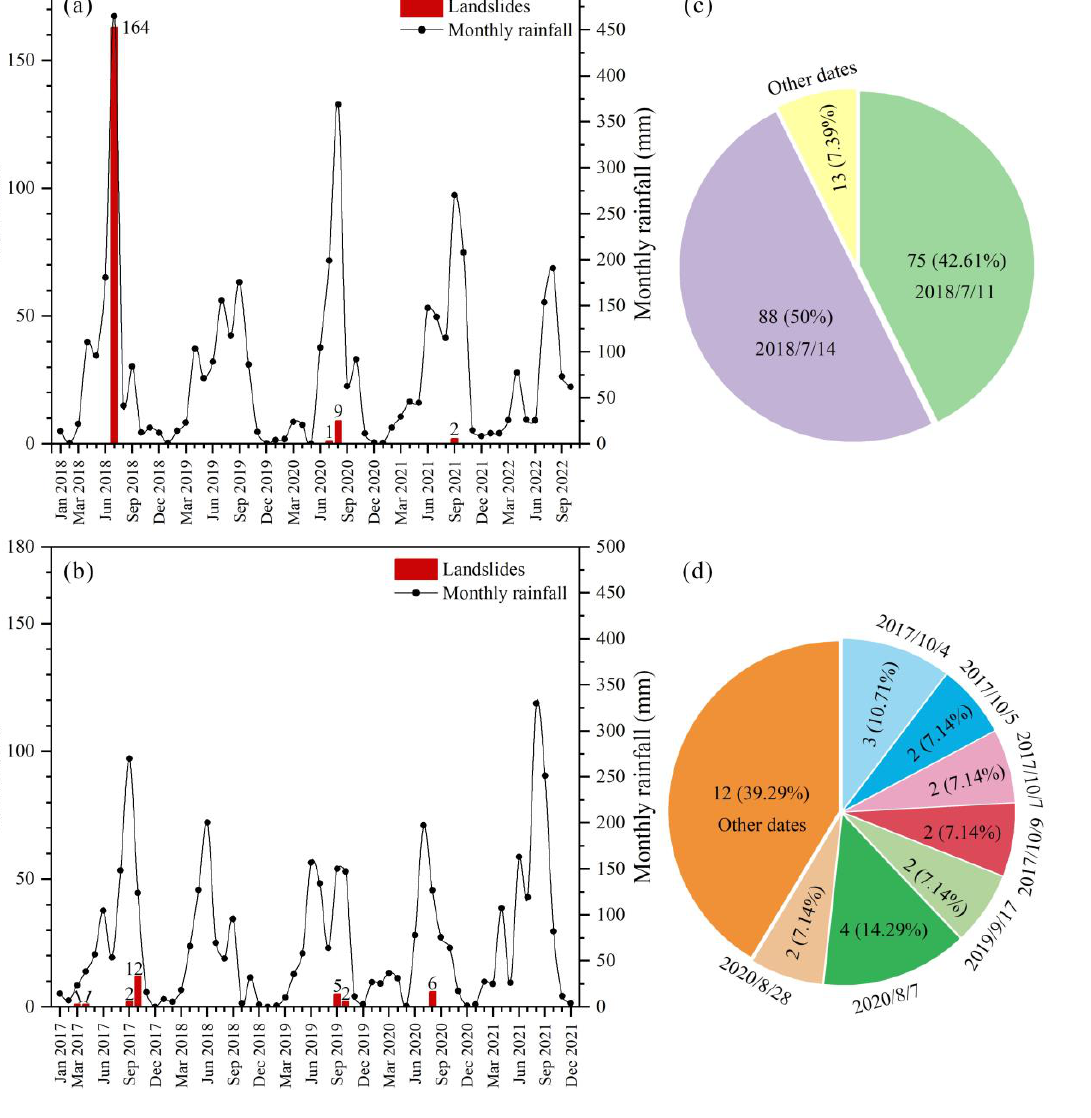
Figure 2. ( a , b ) Comparison between monthly rainfall and number of landslides for LY and XY counties, respectively; ( c , d ) Date distribution of landslides for LY and XY counties. The total number of landslides occurred in July of 2018 in LY is 164: 1 on 10th, 75 on 11th, 88 on 14th.